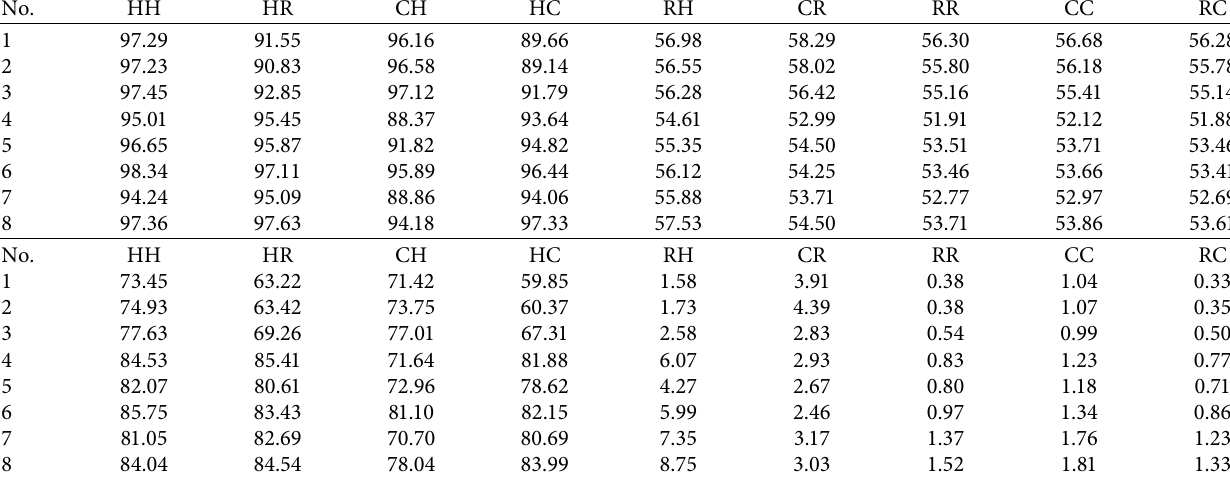
Table 5: Mean percentage qualities of the best-found schedules returned by the LS algorithms (the top table) and mean percentage improvement of the lengths of schedules returned by the LS phase with respect to the lengths of schedules returned by the initialization phase (the bottom table) for each of the eight classes of SCP1 with cov � 80%.